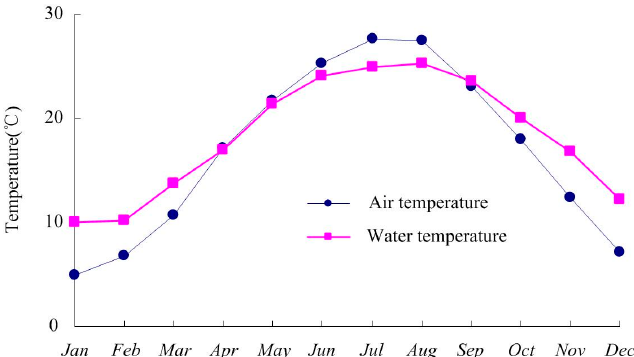
Figure 2. Mean monthly air and water temperatures of the Yichang hydrology station in the period 2000–2004.